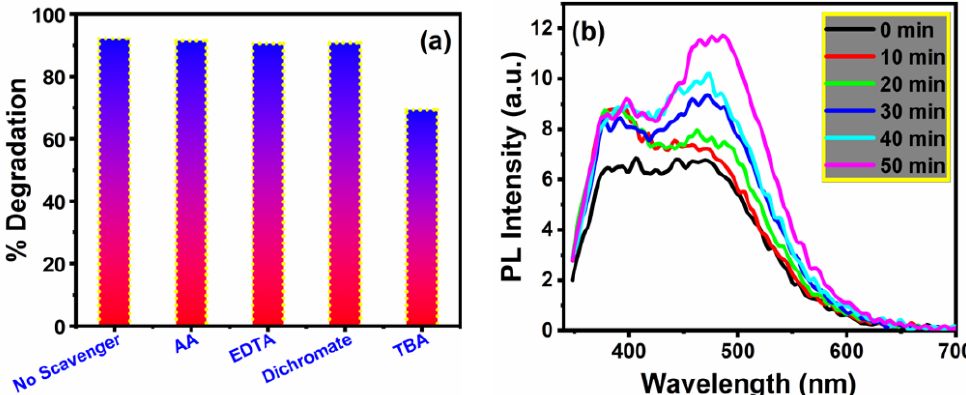
Figure 8. ( a ) Effects of different scavengers on degradation efficiency of RB and ( b ) photoluminescence spectrum against irradiation time.